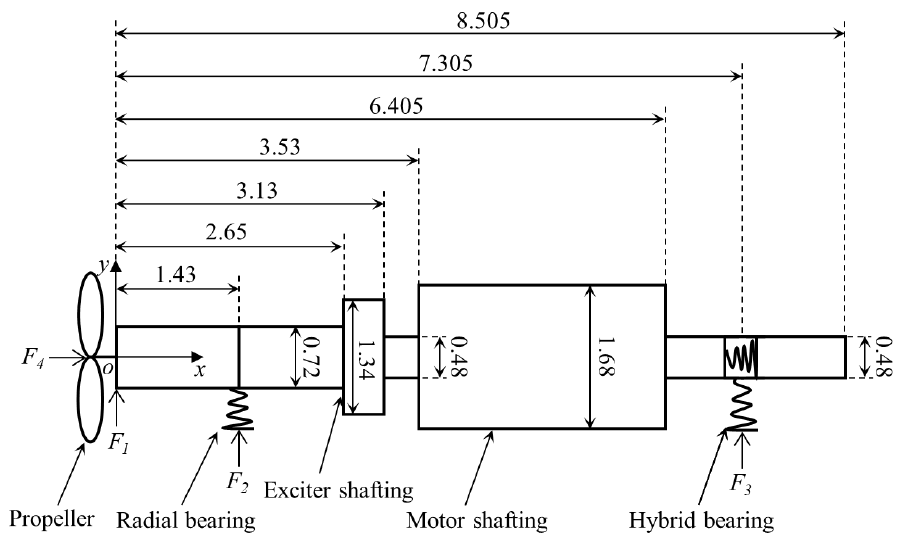
Figure 2. Schematic diagram of the calculation model. The unit of location and diameter is m .